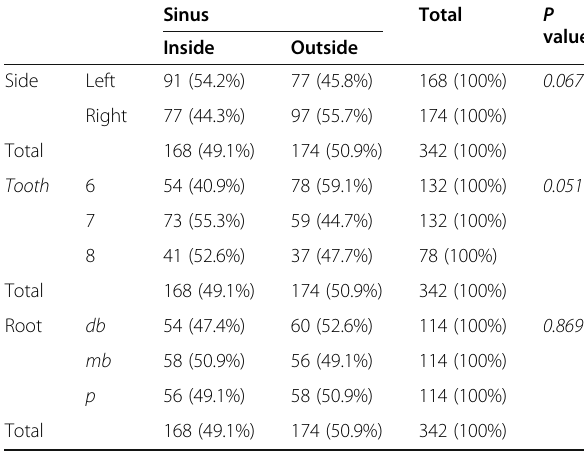
Table 3 The number and percentage of the roots intruding and extruding the sinus in each side, each molar, and each type of root and their corresponding p values (6 = first molar, 7 = second molar, 8 = third molar, db = distobuccal, mb = mesiobuccal, and p = palatal)